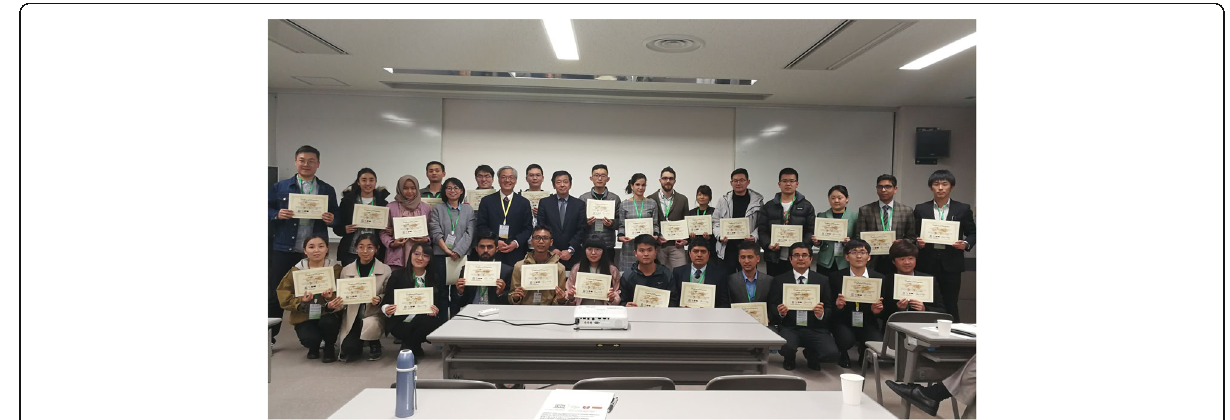
Fig. 8 Group photo of the students with